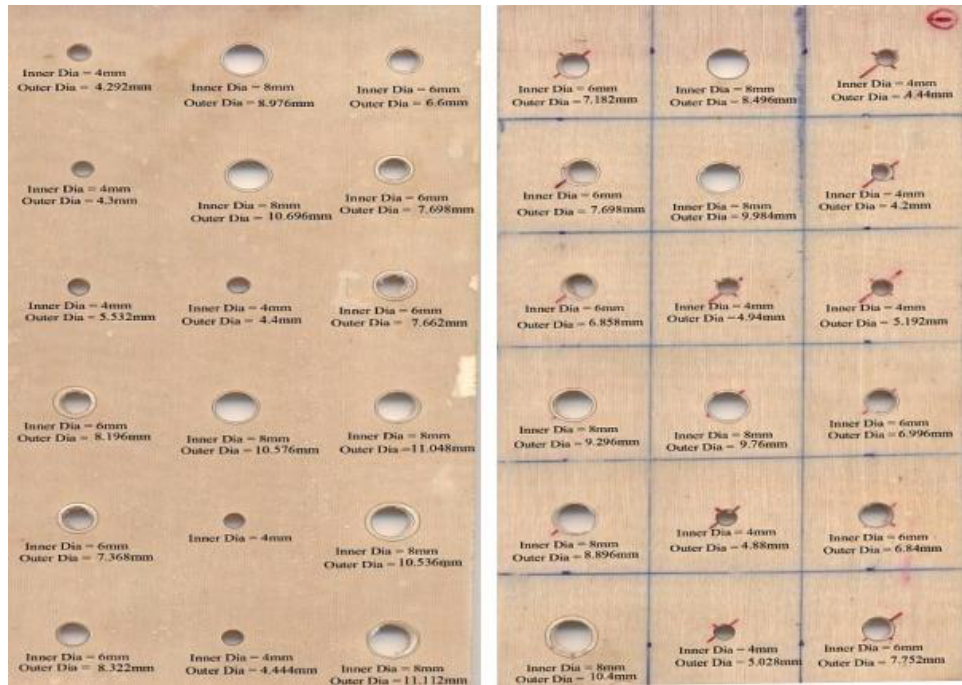
Figure 7. Drilled holes of different diameters and accuracies in bamboo/polyester composites [103]